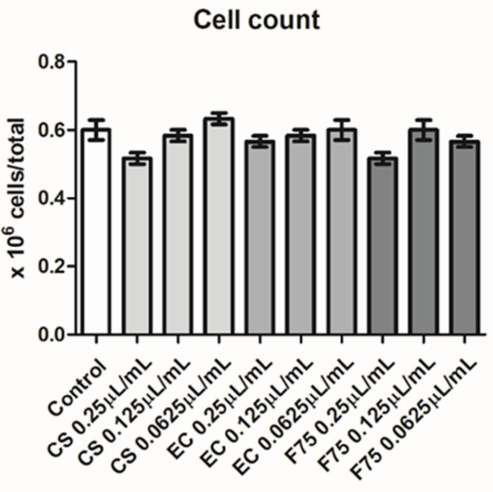
Figure 3. Null effects of the industrial hemp essential oils (CS), (EC), and (F75) (0.0625–0.25 µ L/mL) on the viability of the human H1299 lung adenocarcinoma cell